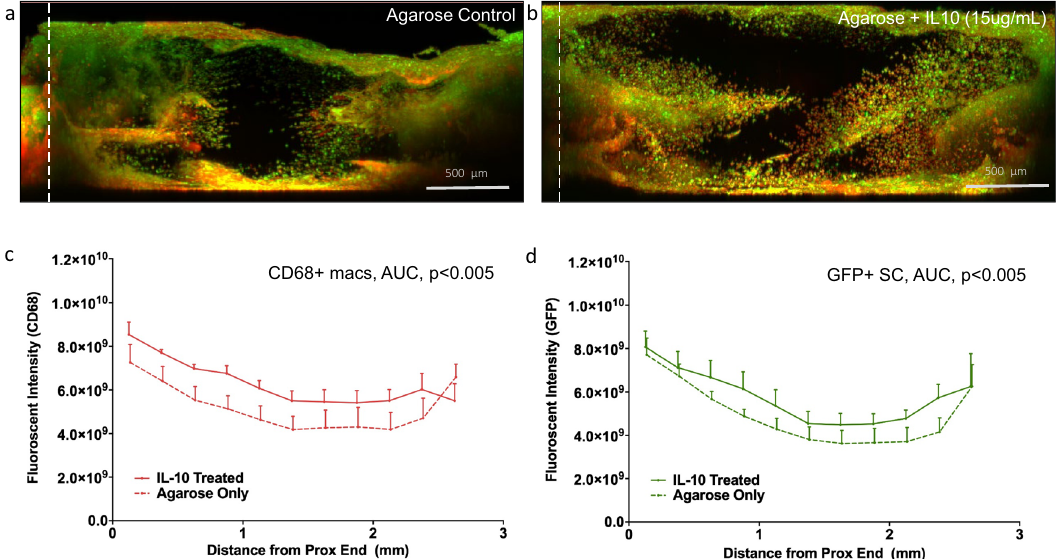
Fig. 5 Transient immunomodulation of macrophage phenotype with exogenous IL10 promotes macrophage recruitment. Representative regenerative bridges from S100b GFP mice after immunohistochemistry staining with CD68 + macrophages (red) GFP + Schwann cells 10 days after 5-mm conduit repair augmented using agarose without ( a ) and with ( b ) IL10 (15 µg/mL) (white line indicates the location of the proximal stump). c Total number of recruited CD68 + macrophages (area under the curve, AUC) and SC ( d ) is increased in the presence of exogenous IL10 ( P < 0.005). Sciatic nerve was transected in WT mice and repaired immediately with a 5 mm conduit fi lled with 0.7% agarose loaded with IL10 at 15 µg/mL or unloaded (negative control). Fluorescent intensity determined for contiguous 250 µm